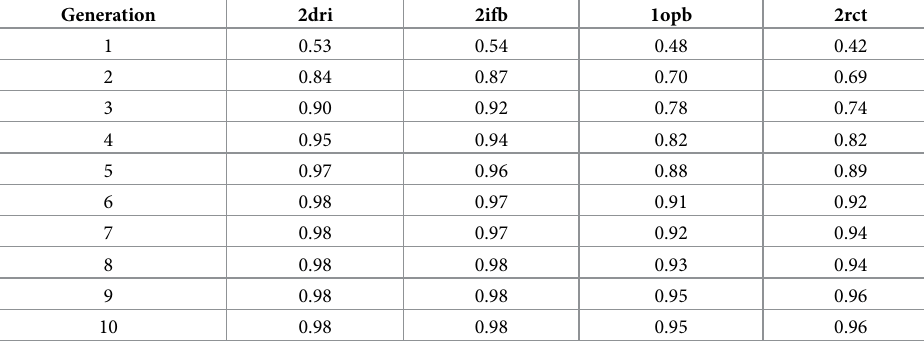
Table 5. Generation-specific PCC values determined for the first ten iterations of four